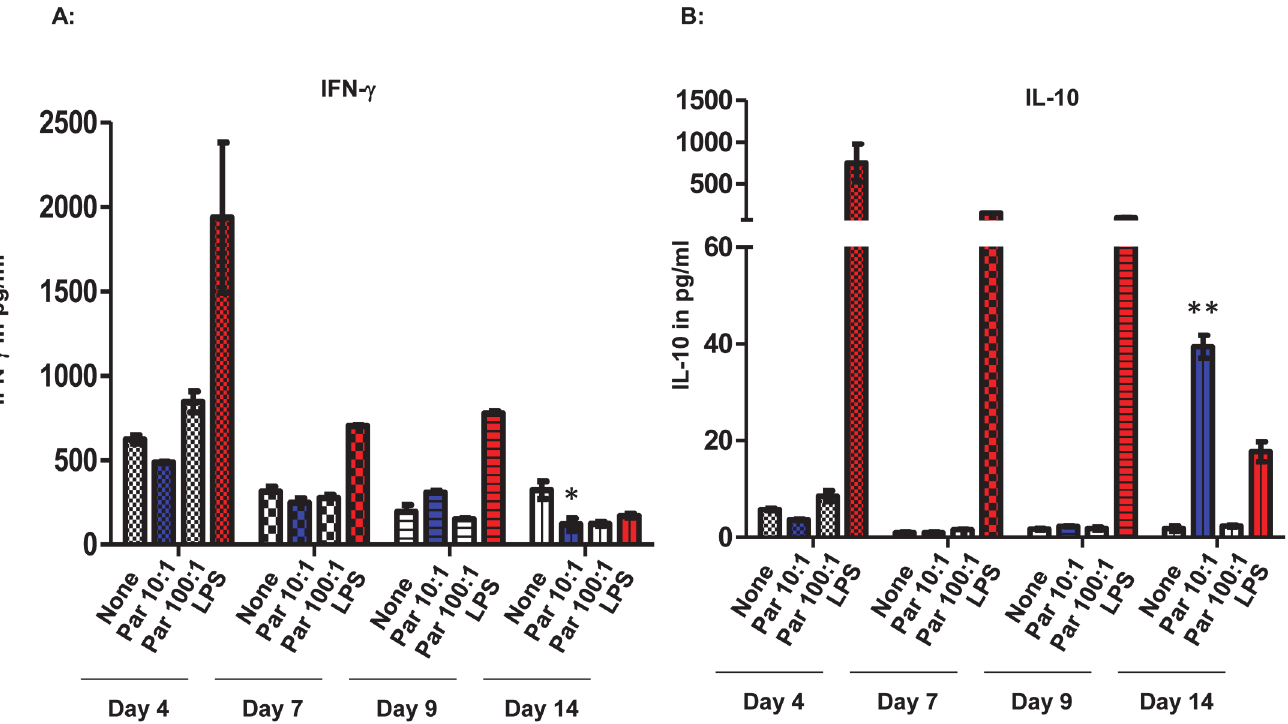
Fig 4. The level of IFN- γ was reduced while IL-10 level was increased in 10:1 treatment supernatants of day 14 culture. The 3-D model was prepared as previously stated, and supernatants were collected on days 4, 7, 9, and 14. Luminex Cytokine Th1/Th2 5-plex Immunoassay kit was used to measure the concentrations of IFN- γ , IL-2, IL-4, IL-5, and IL-10. The results are represented as mean +/- S.E. of three experimental samples from three independent experiments, n = 3. Asterisks, * = p < 0.05, indicate statistically significant IFN- γ decrease in 10:1 particles exposed cells at day 14 compared with those at day 4. ** = p < 0.005 indicate statistically significant IL-10 increase in 10:1 particles exposed cells at day 14 compared with those at day 4.